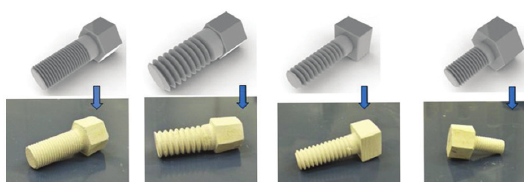
Figure 4. Three-dimensional designs created with SolidWorks 2010 and the corresponding screws machined from Gypsum/PVA